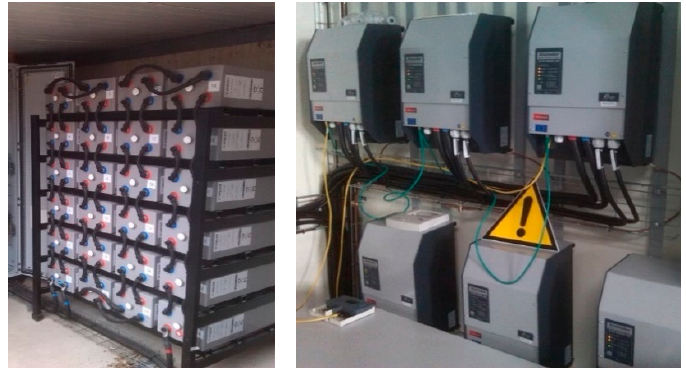
Figure 2. Energy Storage systems (ES): Batteries and inverters/chargers.